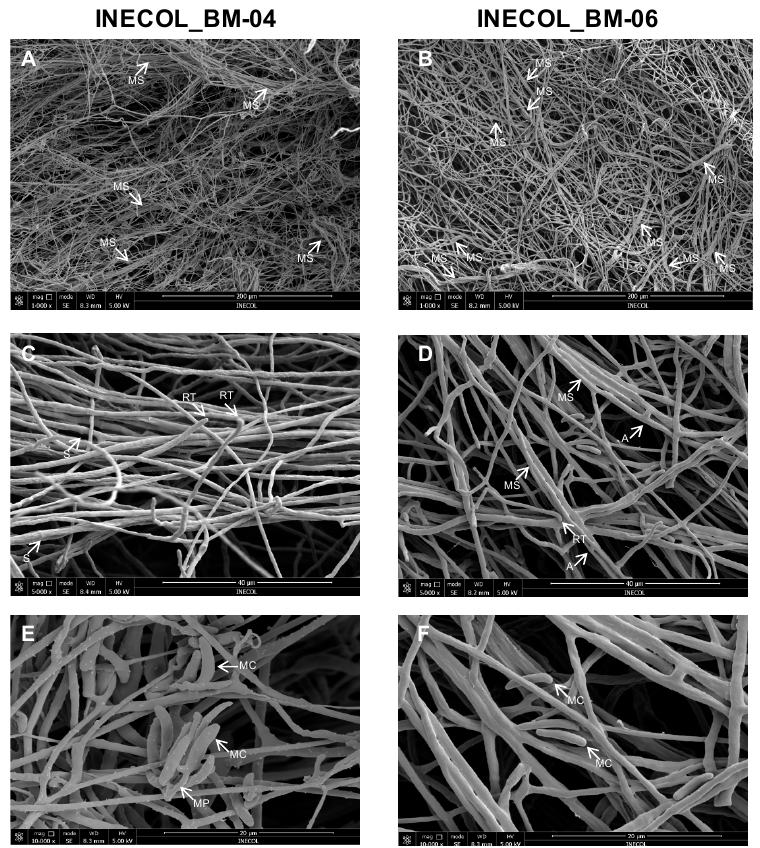
Figure 3. Microscopic features of Fusarium sp. INECOL_BM-04 and Fusarium sp. INECOL_BM-06, evaluated by scanning electron microscopy (SEM). ( A , B ) Micrographs taken at 1000× magnification. ( C , D ) Micrographs taken at 5000× magnification. ( E , F ) Micrographs taken at 10,000× magnification. MS: myceliar strand; S: septum; RT: rounded tip; A: anastomosis; MP: monophialide; MC: micro- conidia.